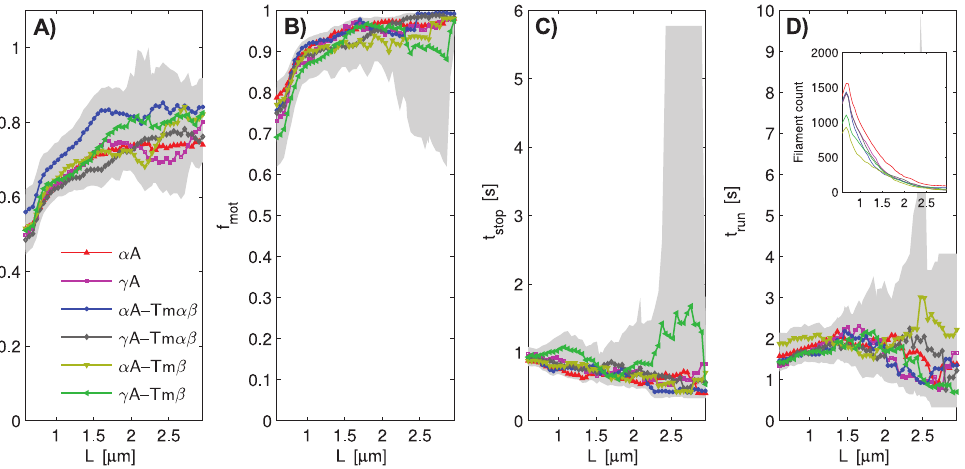
Figure 2. Invitro actin sliding features resolved by filament length. Panels A–D show the actin sliding features average sliding velocity ( V ), motile fraction ( f mot ), stop time ( t stop ), and run time ( t run ), respectively. Sliding window range 0.3–3.25 m m, window width 0.59 m m, 50 equally spaced windows, 500 bootstrap data sets per condition, gray areas are 95% confidence intervals. Inset in panel D: number of filaments within length windows, counted separately for each protein combination. Note that L does not start at 0 m m, but at 0.6 m m.